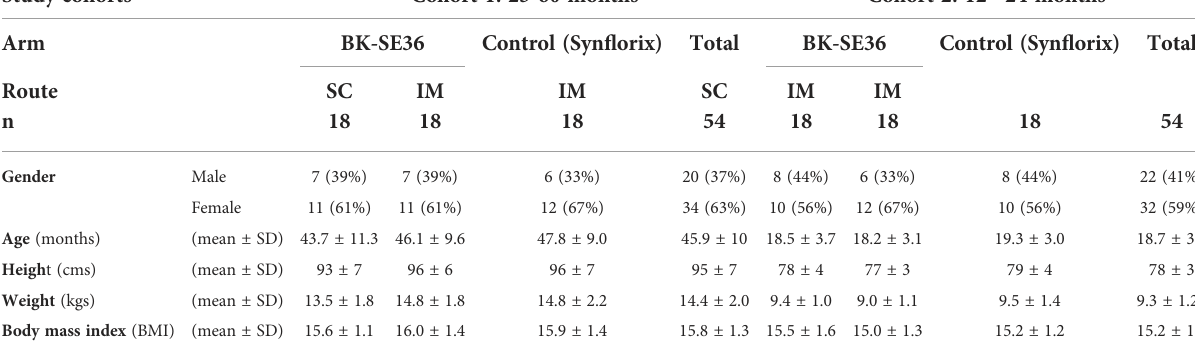
TABLE 1 Baseline characteristics of the study participants at enrollment within each vaccine